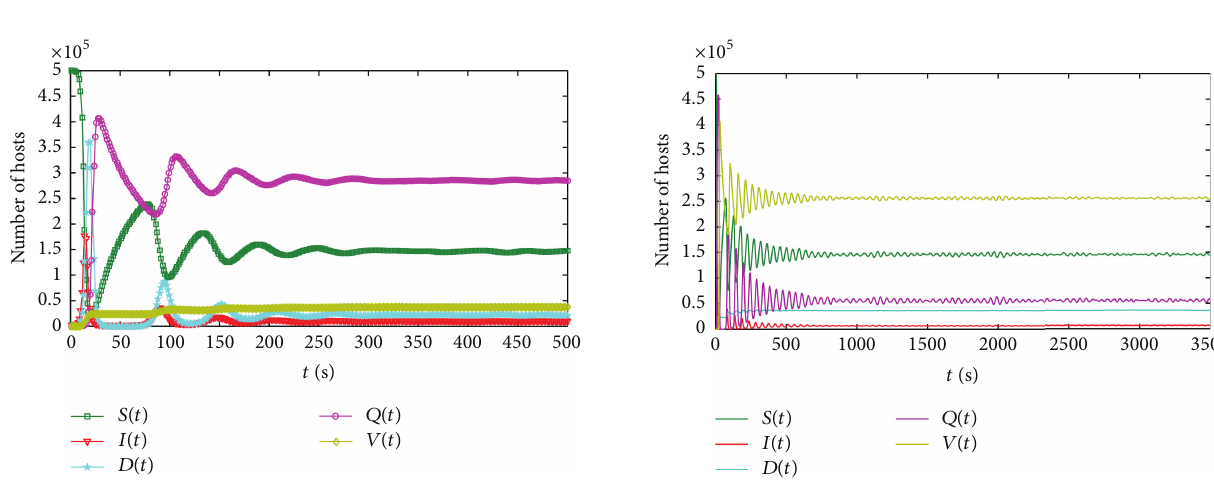
susceptible 𝑆(𝑡) and infected 𝐼(𝑡) is depicted when 𝜏 = 15 < 𝜏 0 as shown Figure 11. It shows that the curve is converged to a fixed point, which means that the system gets stable.